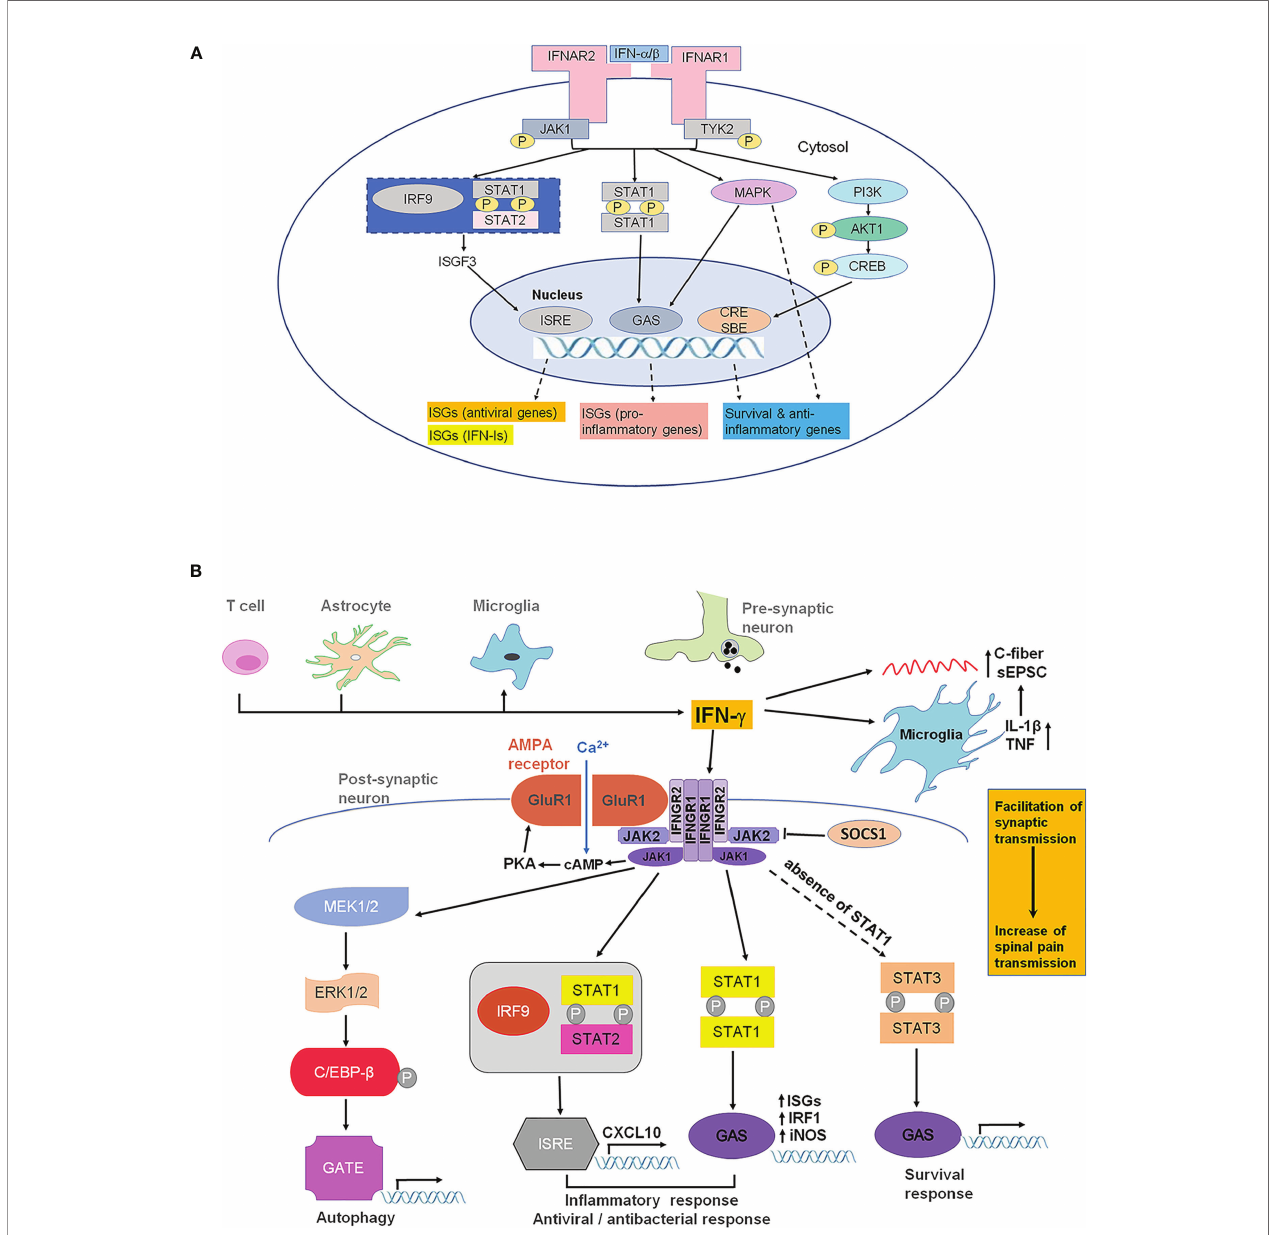
FIGURE 2 | IFNAR and IFNGR signaling. (A) IFNAR signaling and type-I IFN-induced gene expression. IFN- a and IFN- b transmit signals through IFNAR1 and IFNAR2 (the main ligand-binding subunit). IFNAR1 and IFNAR2 are distinctly associated with TYK2 and JAK1, respectively. Activation of TYK2 and JAK1 results in activation of STAT1/2, as well as PI3K and MAPK, leading to the transcription of ISGs, including antiviral genes, type-I IFN genes, pro-in fl ammatory genes, as well as survival and anti-in fl ammatory genes, through ISRE, GAS, and CRE/SBE. Additionally, TYK2 may be associated with membrane proteins, such as ion channels, causing rapid modulation of cellular function. CRE, cyclic AMP response element; GAS, IFN- g -activated sites; ISG, interferon-stimulated genes; ISRE, IFN-stimulated response elements; JAK1, Janus kinase 1; MAPK, mitogen-activated protein kinase; PI3K, phosphoinositide 3-kinase; SBE, smad binding elements; STAT, signal transducer and activator of transcription; TYK2, tyrosine kinase 2. (B) IFN- g and IFNGR signaling in the spinal cord for the pathogenesis of pain. IFN- g can be released by T lymphocytes, astrocytes and microglial cells under pathological pain conditions (e.g., nerve injury). IFN- g can directly and indirectly alter synaptic activity in spinal dorsal horn neurons and thereby contributes to hyperactivity (central sensitization). IFN- g facilitates Ca 2+ -permeable AMPA receptors (AMPAR) coupled with IFNGR. These AMPAR lack GluR2 and induce neurotoxicity. IFN- g can directly activate microglia and increase the release of glial mediators, such as IL- g and TNF that modulate synaptic strength and facilitated monosynaptic C- fi ber-evoked excitatory postsynaptic currents. IFNGR composes of IFNGR1 and IFNGR2 subunits, which are associated with the kinases JAK1 and JAK2. In canonical IFN- g signaling, phosphorylation of JAK1 and JAK2 results in the phosphorylation of STAT1. A STAT1 homodimer translocates to the nucleus and binds to GAS in the promoters of IFN- g -regulated genes (IGS) such as NOS-2 and IRF1. In cells that do not express STAT1, STAT3 can be phosphorylated by JAK1/JAK2, resulting in translocation of the STAT3 dimer to the GAS